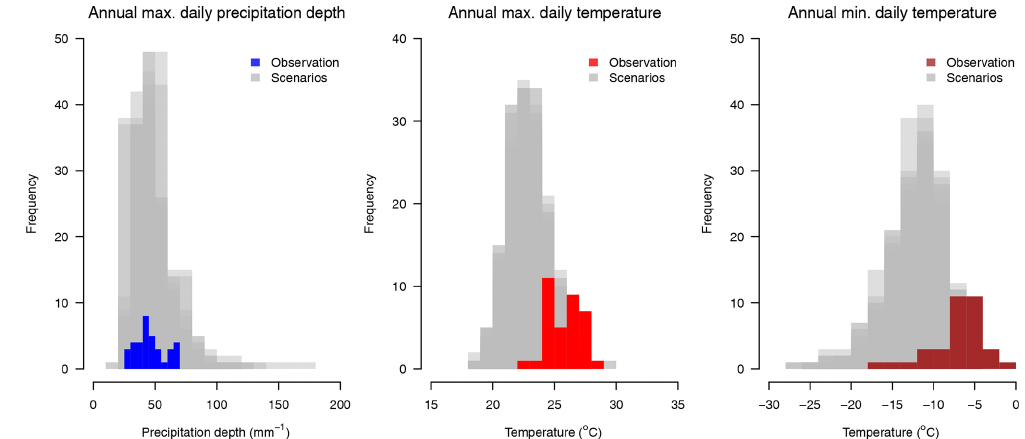
Figure D1. Variability in 100 meteorological scenarios used in this study vs. observations.